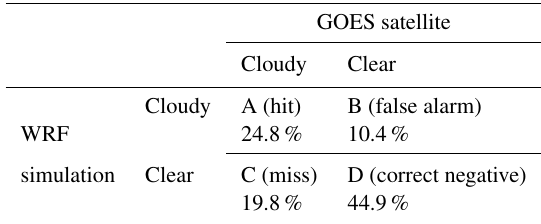
Table 2. Contingency table for WRF simulation and GOES satellite clouds. The number of data for each category is normalized by the total number of data.